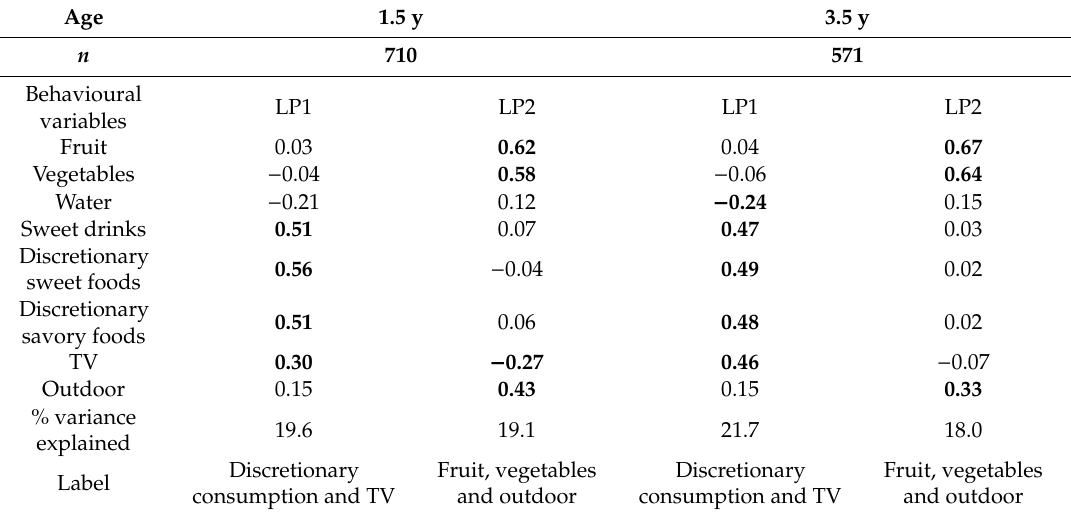
Table 3. PCA loadings for lifestyle patterns (LP) derived at 1.5 y and 3.5 y in the pooled datasets (InFANT and InFANT Extend studies combined).